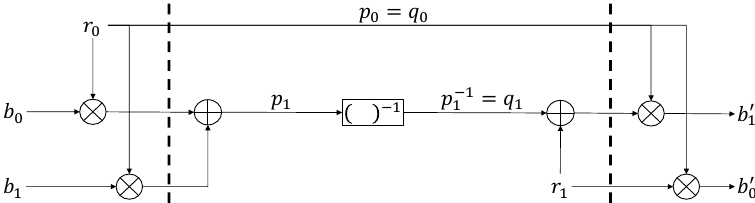
Figure 2: First-order shared implementation of an inversion in F q . The dashed lines depict